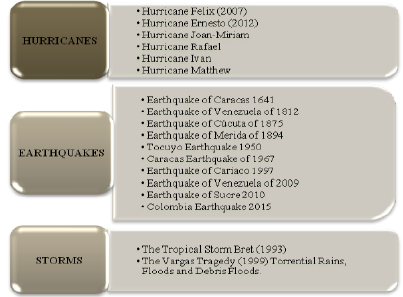
Figure 1. Major disasters occurred in Venezuela